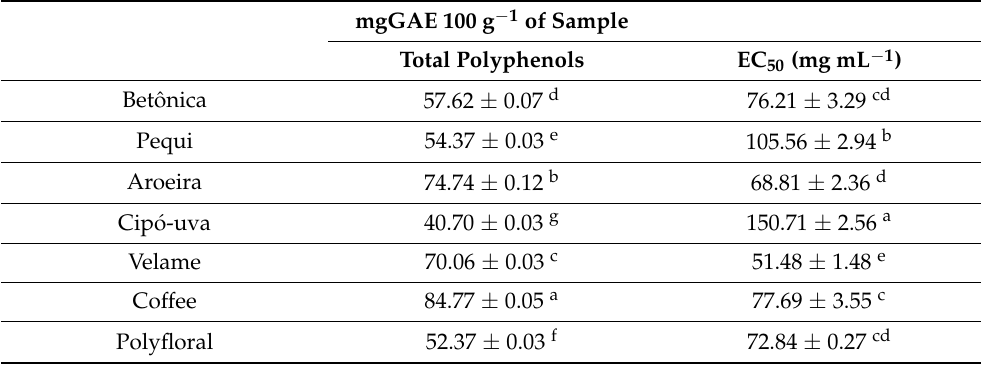
Table 7. Data on the contents of total polyphenols and EC 50 (mean ± SD; n =